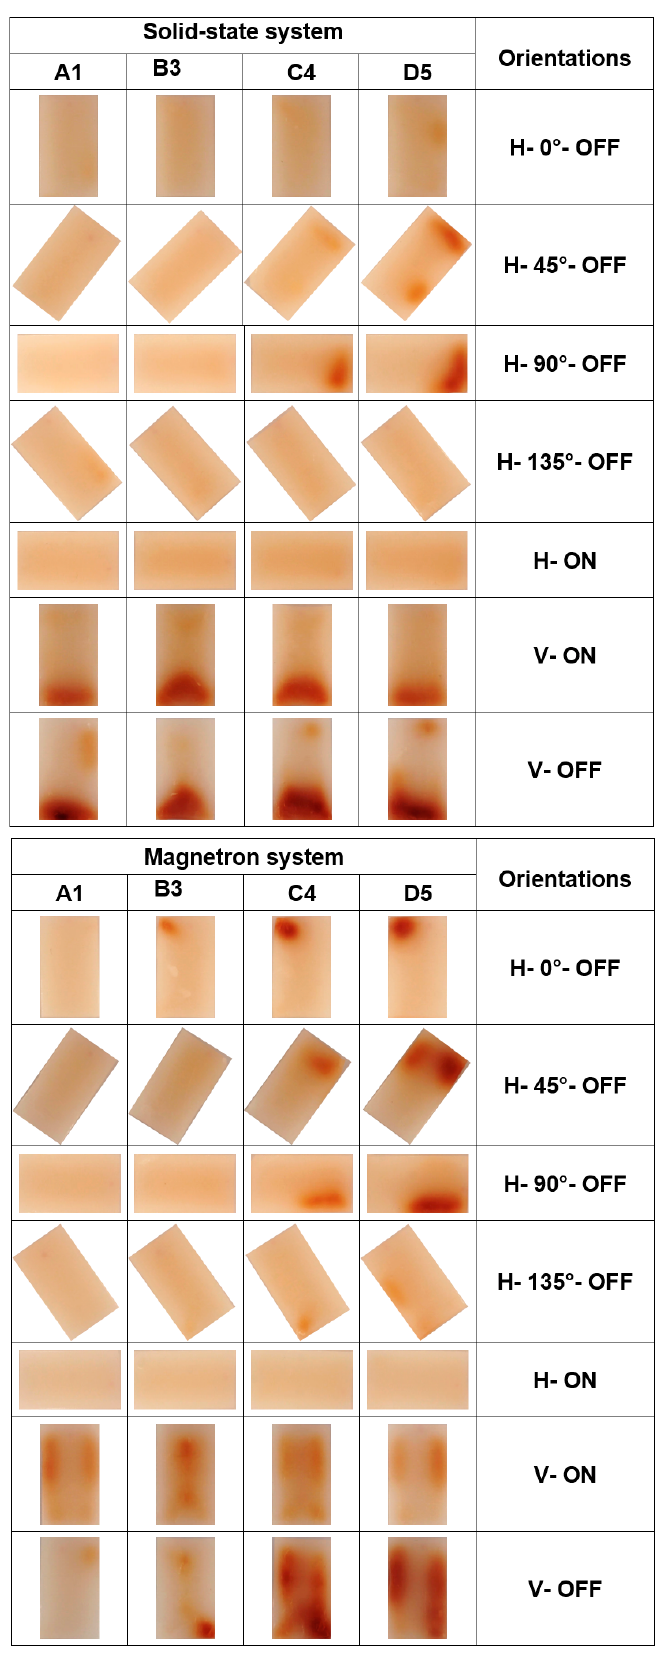
Figure 7. Photographs of sample surfaces A1, B3, C4, and D5 processed at different orientations after 120 s heat processing in the solid-state and magnetron microwave systems.